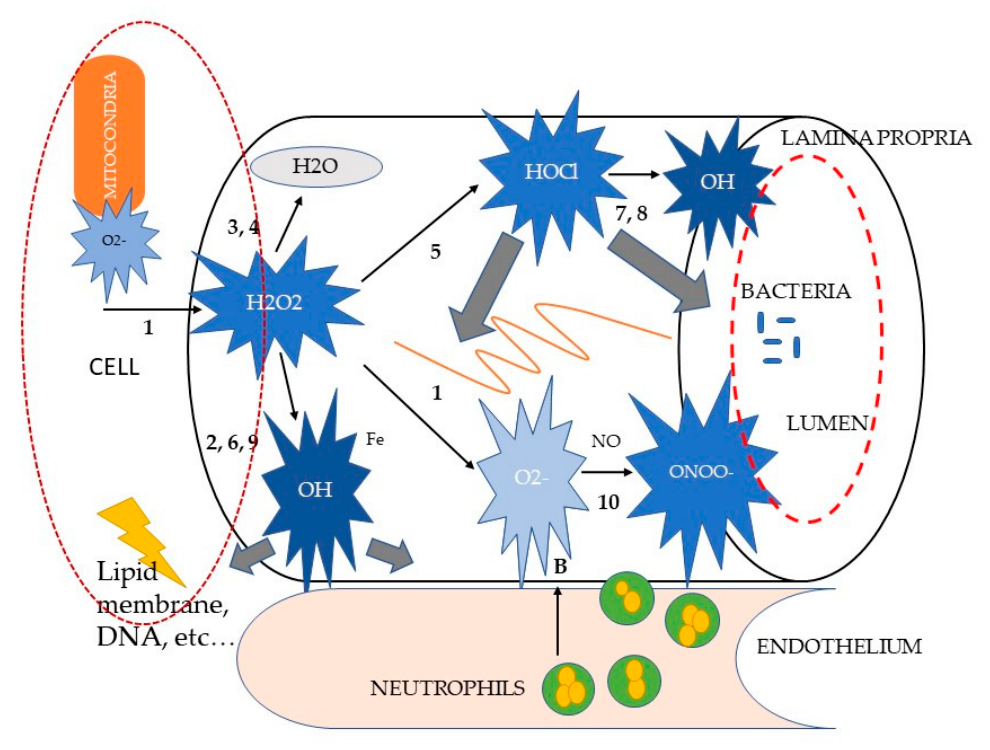
Figure 1. Schematic representation of reactive oxygen metabolite (ROM) reactions in intestinal inflammation, modified from [66]. Letters indicate the sources of ROM (A, neutrophil NADPH oxidase; B, xanthine oxidase; C, mitochondrial NADPH cytochrome p450 reductase). Numbers correspond to the (anti)oxidant reactions cited in the text. The large grey arrows indicate possible ROM targets (membrane lipids, proteins, DNA, matrix blood vessels, bacteria). Fe, ferrous iron; H 2 O 2 , hydrogenperoxide; HOCl, hypochlorous acid; MT, metallothionein; NO, nitric oxide; O 2 • – , superoxide anion; • OH, hydroxyl radical; ONOO–, peroxynitrite.